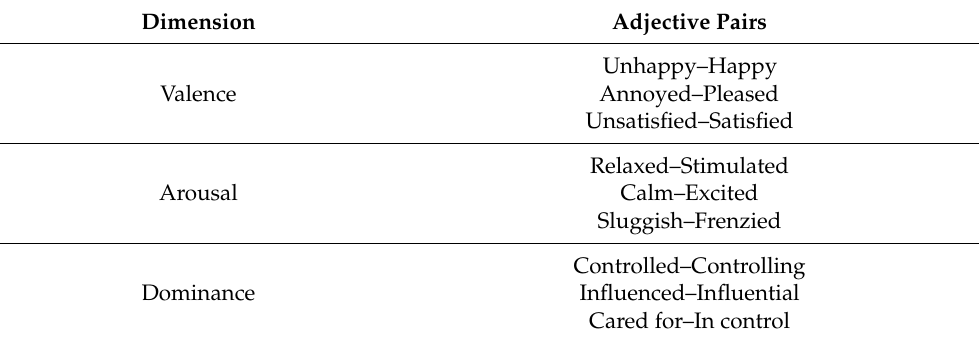
Table 1. Adjective pairs associated with valence, arousal and dominance